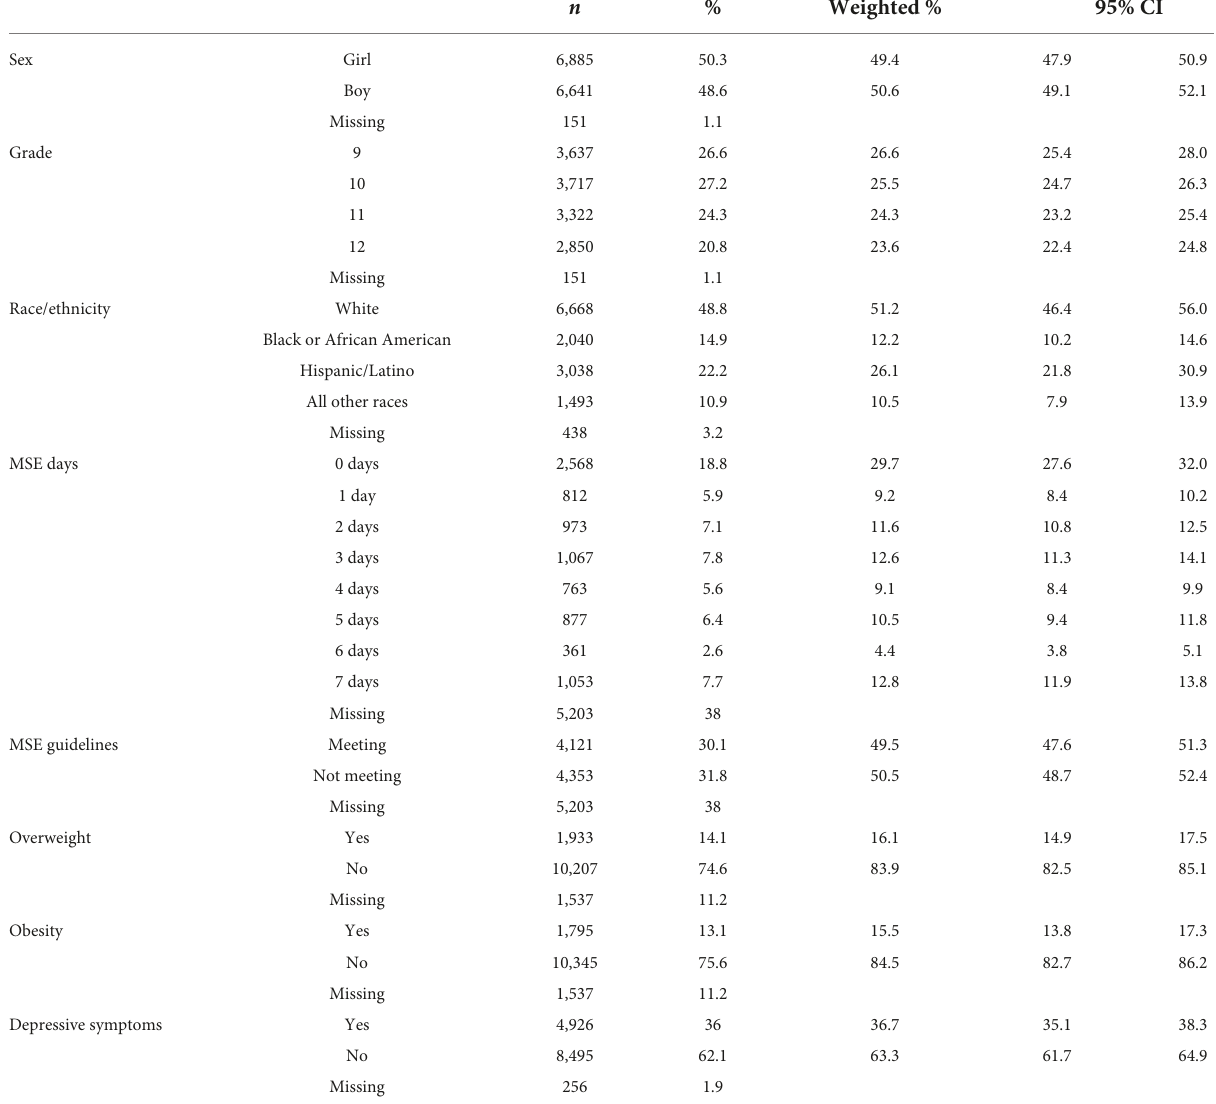
TABLE 1 Sample characteristics of study